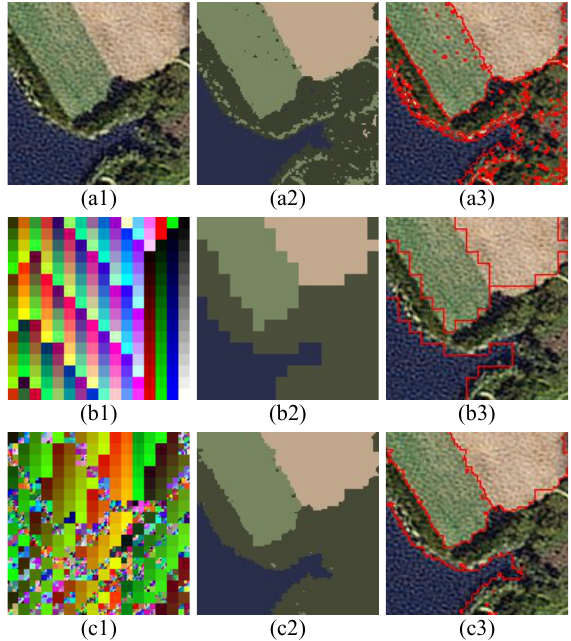
Figure 4. SPOT image and its segmentation results. (a1) SPOT image, (a2)-(a3) HMRF-FCM, (b1)-(b3) RT-HMRF- FCM, (c1)-(c3) The proposed algorithm In Figure 5, there are high variance forests and thin roads.